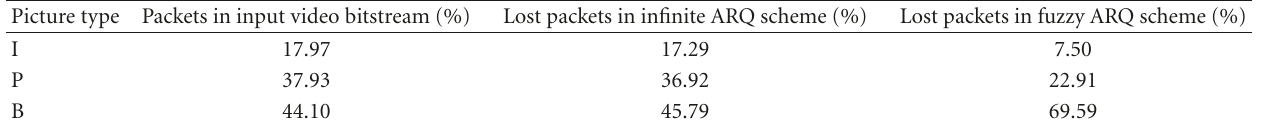
Table 3: Percentage distribution of input and lost packets by picture type.